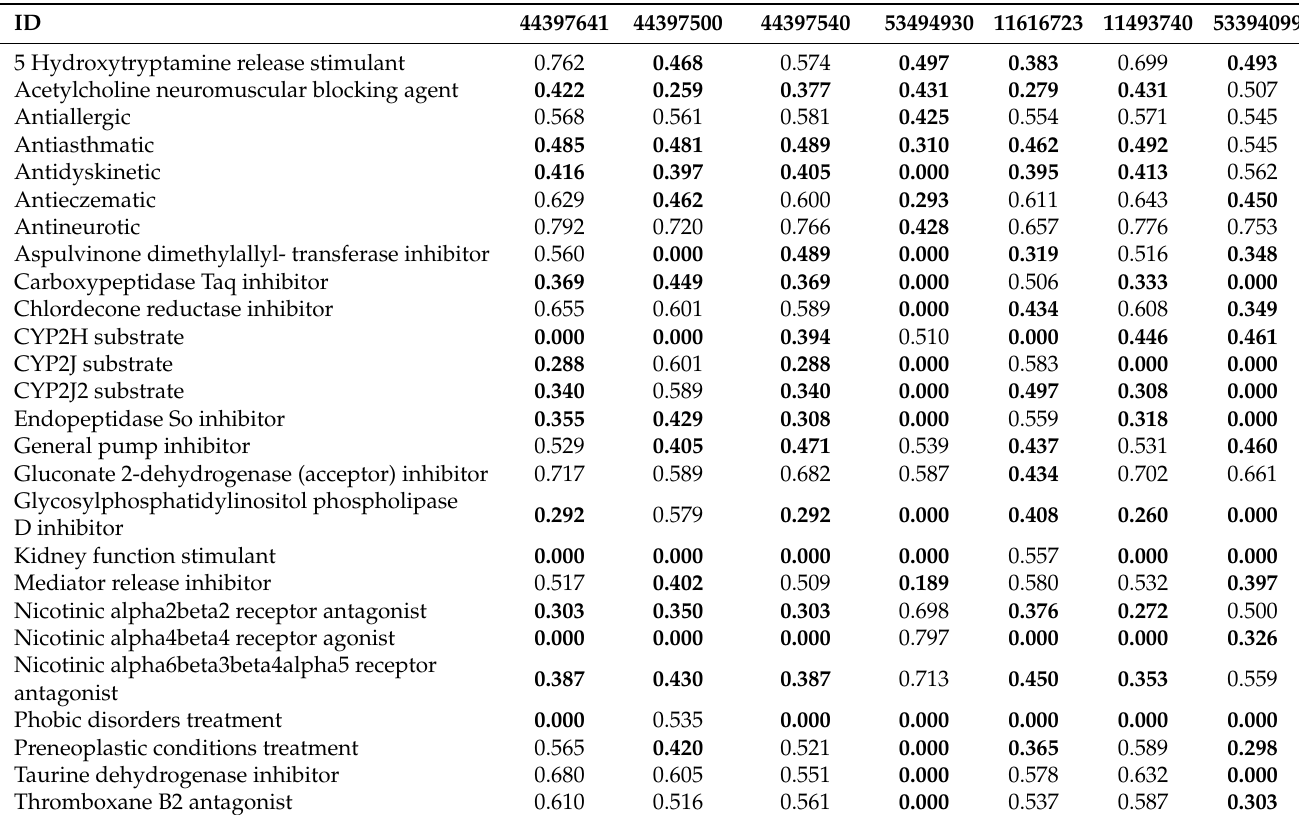
Table 10. The series of probabilities used to perform the Kruskal–Wallis test on Group 2. The bold numbers are probabilities less than